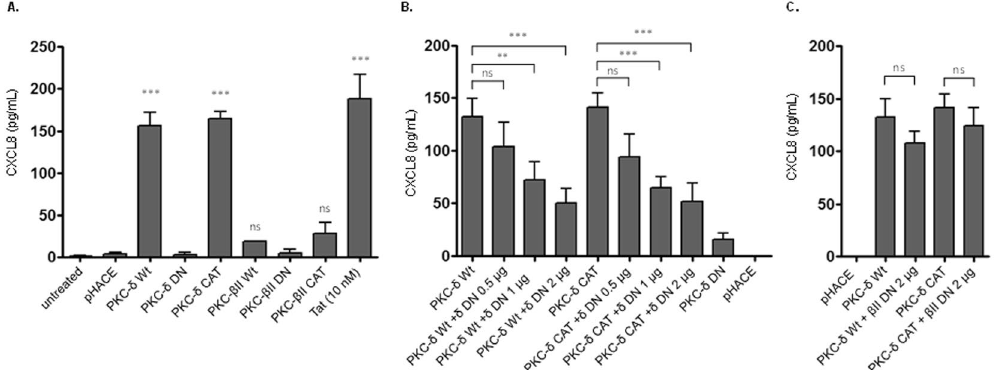
Figure 4. PKC- δ activation is sufficient to induce CXCL8 production. ( A ) HEK cells (10 6 cells) were transfected with 0.5 µ g of the different plasmid construction (as inducated) for 48 hours. Medium was renew 24 h post- transfection. After 24 h of incubation in the presence or absence of Tat protein (10 nM) cell supernatants were collected and CXCL8 production was quantified in by ELISA. The data represent means and standard deviation (SD) of three independent experiments. ( B,C ) HEK cells (10 6 cells) were transfected with 0.5 µ g of Wt or CAT PKC- δ in the presence of increasing amount of DN PKC- δ (0.5–2 µ g) in ( B ) or 2 µ g of PKC- β II DN in ( C ). After 48 hours of incubation cell supernatant was collected and CXCL8 production was quantified by ELISA. The data represent means and standard deviation (SD) of three independent experiments. Statistical significance comparing different group were analysed with one-way ANOVA followed with a Bonferroni post tests and are denoted with * for p < 0.05, ** p < 0.01, *** p < 0.001, ns non-significant. Comparisons are indicated by a black line above the